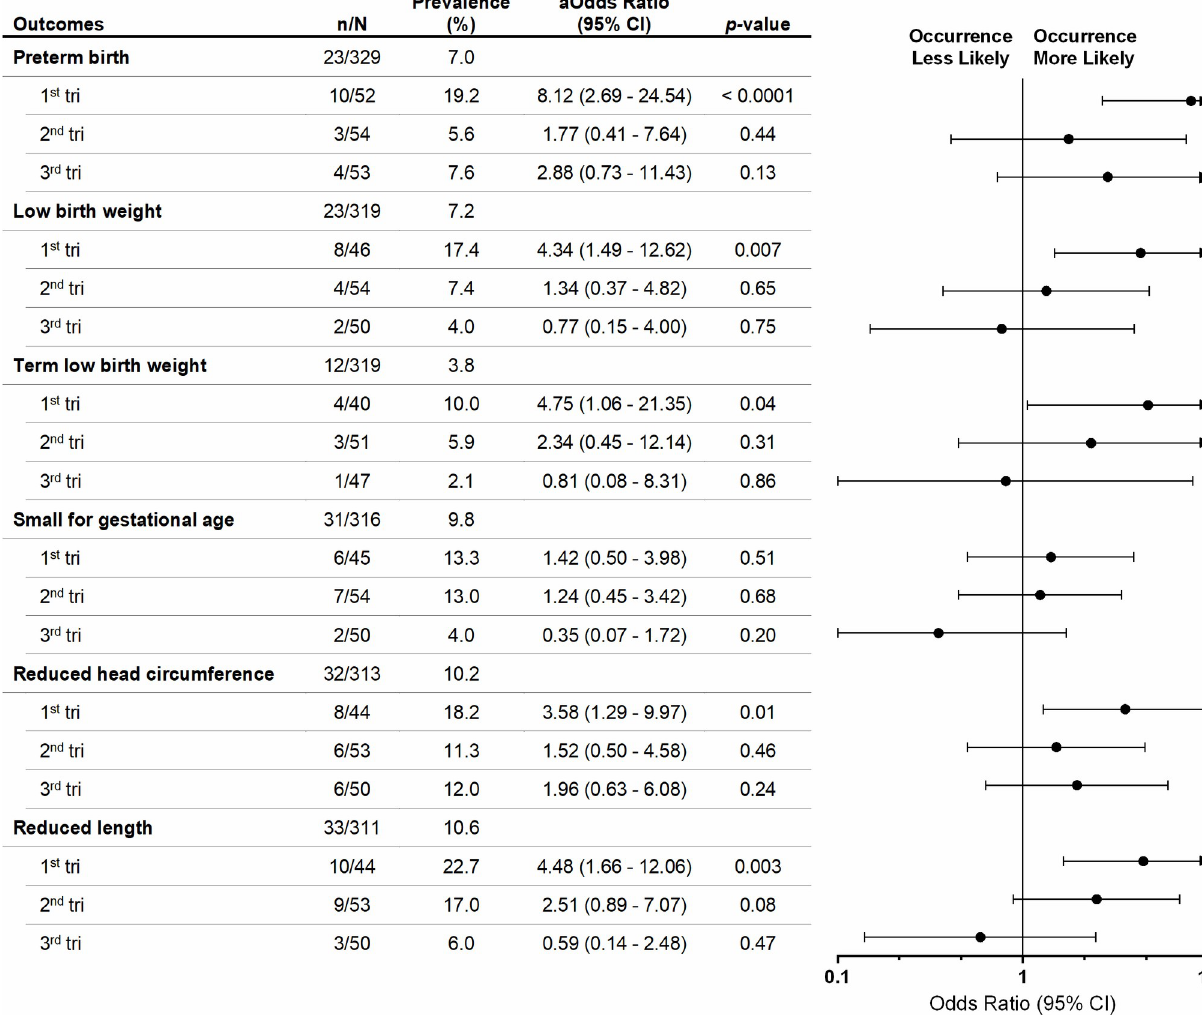
Fig 2. Association between adverse pregnancy outcomes and P . vivax infections according to the trimester of first infection. Forest plot of odds ratios of adverse events in newborns from women infected during pregnancy compared with newborns from non-infected women is shown. n/N— number of events by total number of individuals in each group; aOdds Ratio—adjusted Odds Ratio; CI—confidence interval; tri—gestational trimester. Odds ratios were adjusted (aOR) for maternal age, gravidity status, residence, education level and occupation. Preterm birth–birth < 37 th week of gestation; Low birth weight–birth weight < 2500 g; Term low birth weight–birth weight < 2500 g from 37 th week of gestation; Small for gestational age, Reduced head circumference and Reduced body length–birth weight, head circumference and length (respectively) < 10 th centile for sex-specific gestational age. P-values were estimated through multiple logistic regression